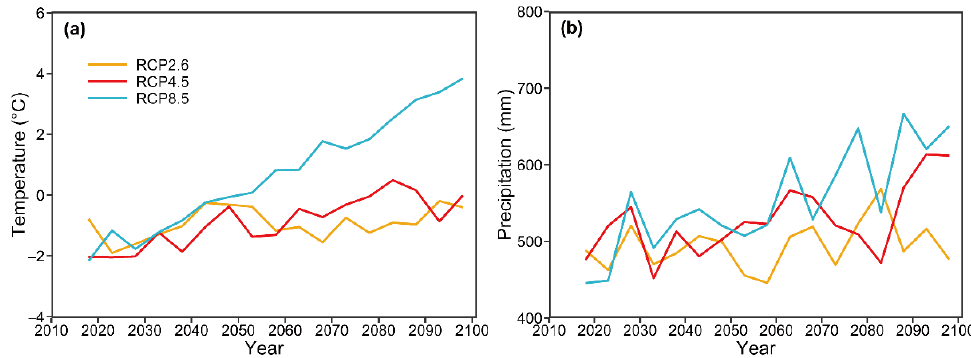
Figure 3. Temporal changes of MAT (°C; panel a ) and MAP (mm; panel b ) under three RCPs.